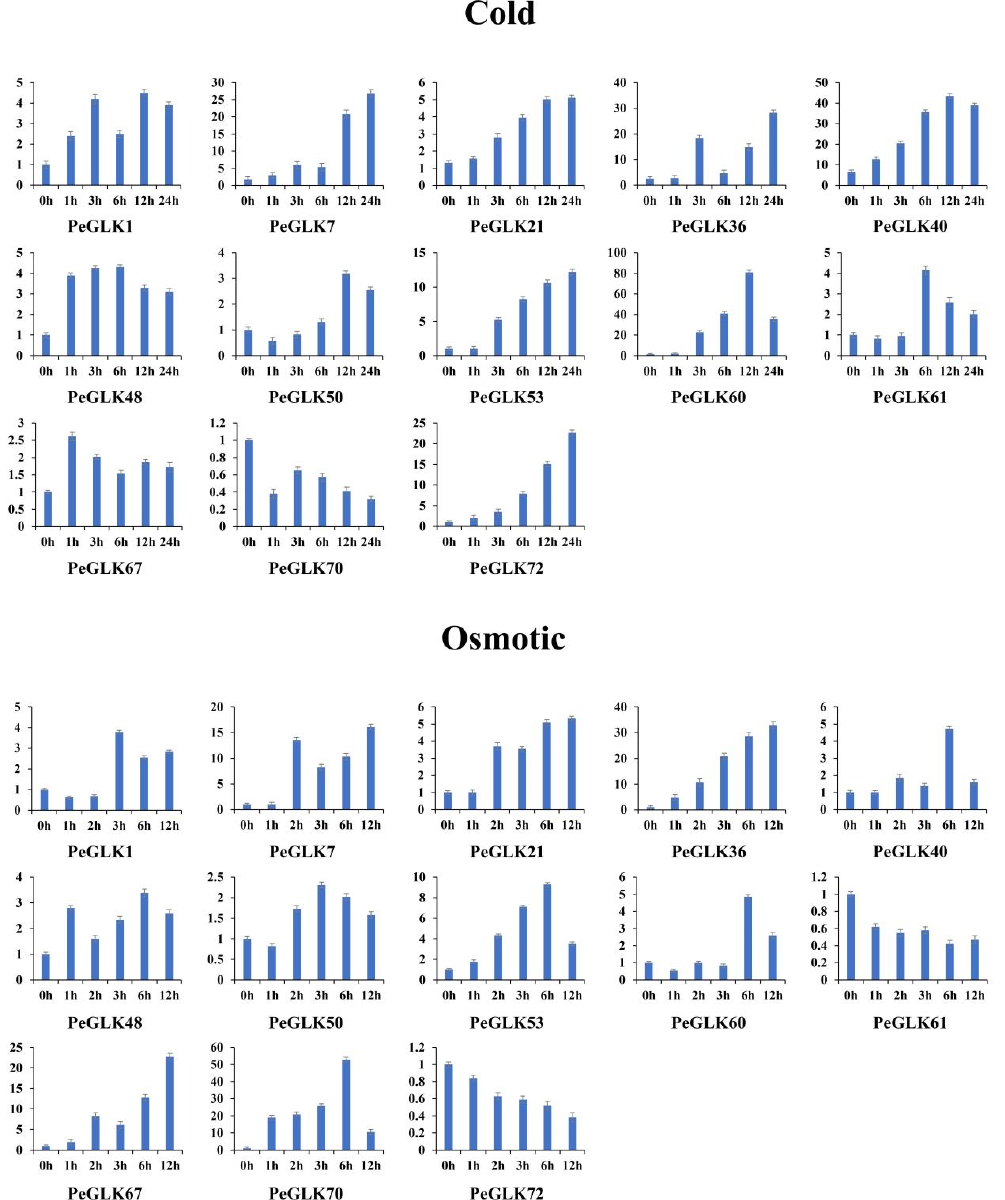
Figure 11. Expression patterns of 13 representative PeGLK genes in response to abiotic stress treat ‐ ments. X ‐ axis and Y ‐ axis indicate time points after cold and osmotic treatments, and relative expres ‐ sion levels are standardized to reference gene TIP41 .